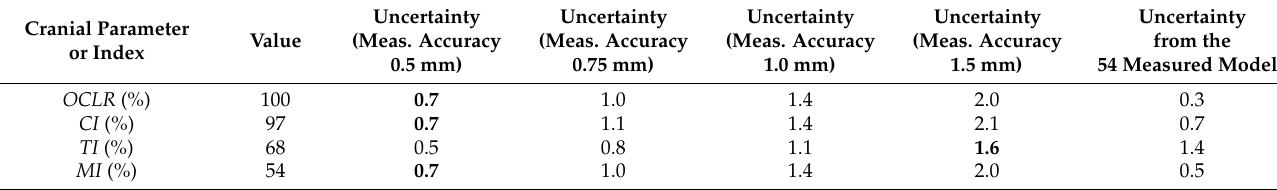
Table 4. Cranial deformation indices along with their corresponding uncertainties for different values of measurement accuracy (0.5, 0.75, 1, and 1.5 mm). Experimental uncertainties derived from the 54 measured models are provided in the last column. The bold values highlight the closest largest